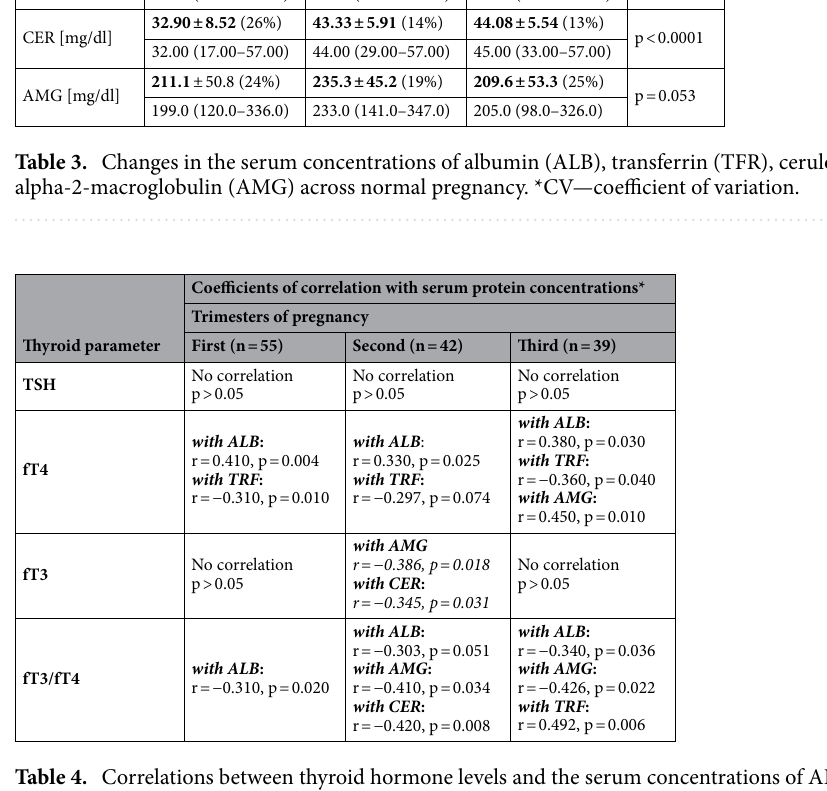
Table 4. Correlations between thyroid hormone levels and the serum concentrations of ALB, TRF, CER and AMG across normal pregnancy. Significant relationships (p <0.05) are marked in bold. *Spearman test.